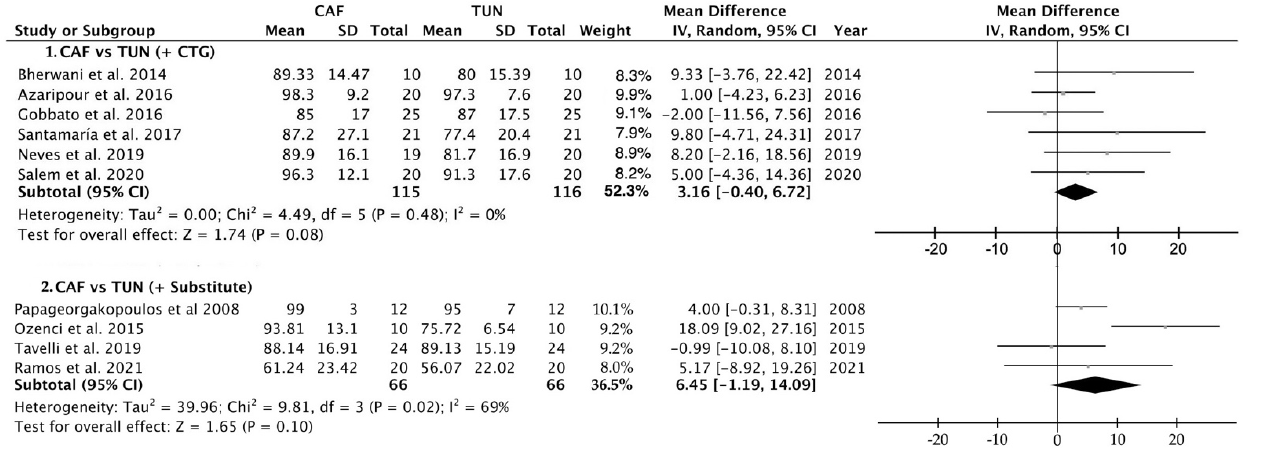
Figure 10. Forest plot for TUN (control group) versus CAF (test group) when comparing the percentage of root coverage after surgical treatment after excluding Tozüm et al. [41] from the analysis. Single and multiple GRs were considered together when using a connective tissue graft or a polymeric substitute. The weighted means are presented with a CI of 95%. Heterogeneity was determined using Higgins (I 2 ). A random-effects model was applied to all analyses. Statistical significance was set at 0.05.